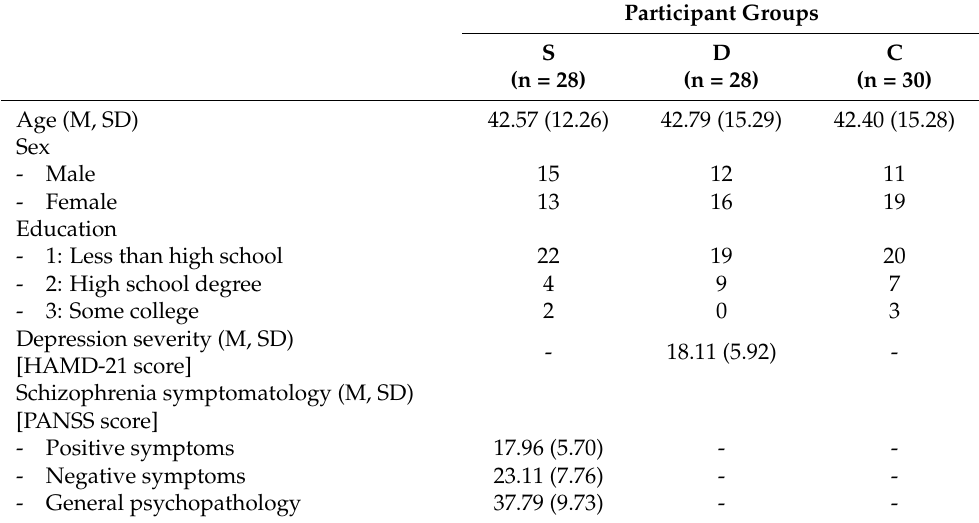
Table 1. Sociodemographic and clinical